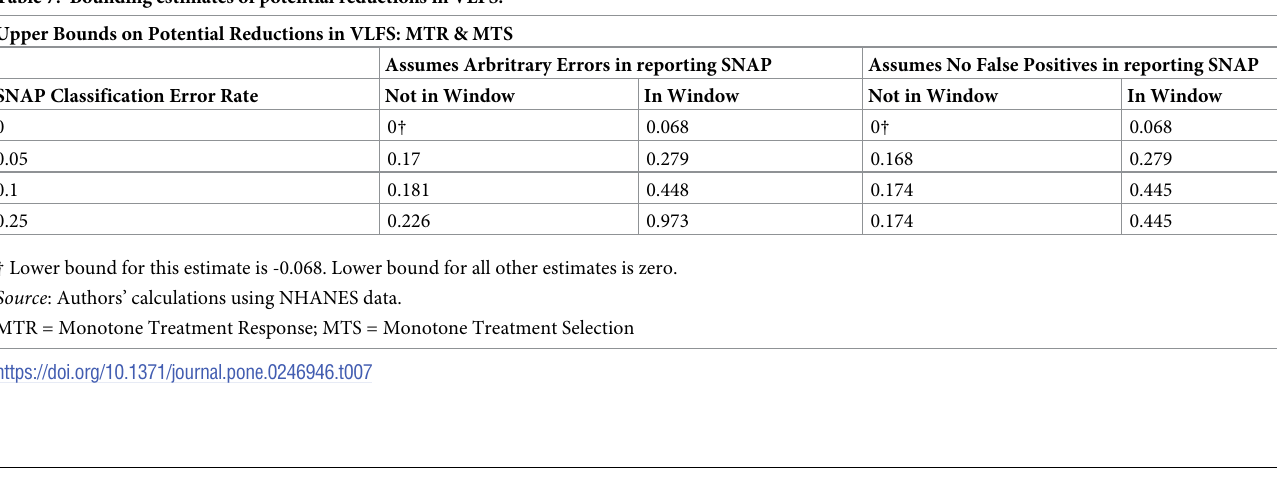
Table 7. Bounding estimates of potential reductions in